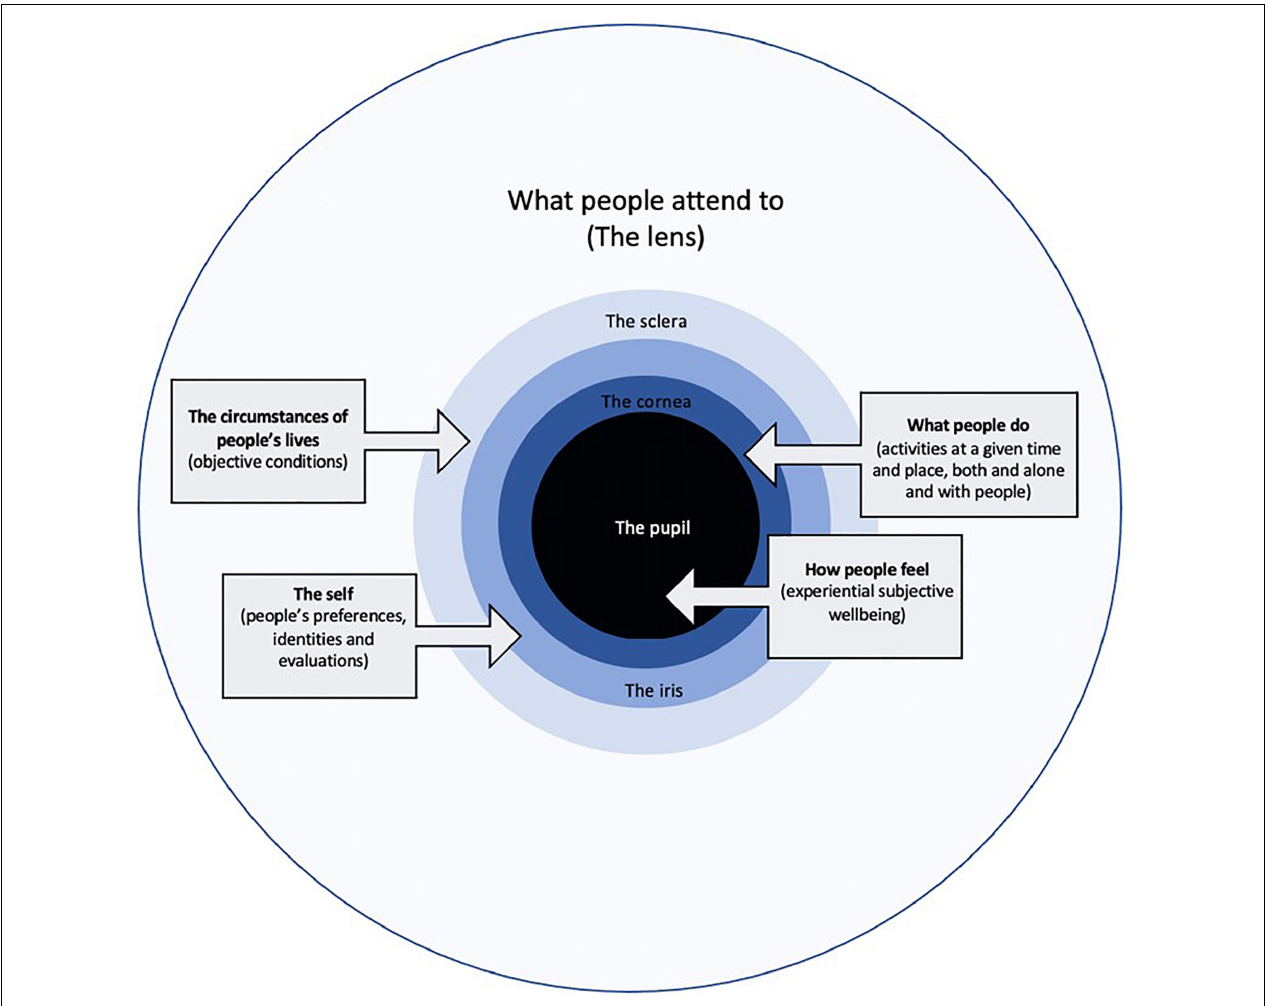
FIGURE 1 | Visualization of the